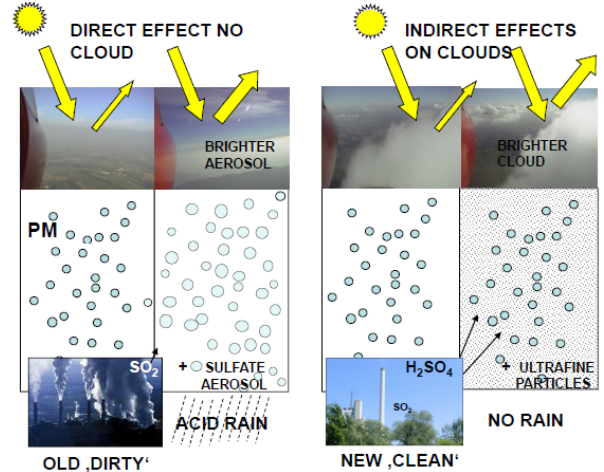
Fig. 1. Old versus new “clean” power plant emission: left (old Fig. 1: Old versus new ‘clean’ power plant emission: left (old power plant) - sulphur power plant) – sulphur dioxide increases the size and scattering co- efficient of particulate matter (PM), but not the number of existing dioxide increases the size and scattering coefficient of particulate matter (PM), but not the or co-emitted particles; right (new power plant) – directly emitted H 2 SO 4 increases the CCN number density and affects cloud micro- number of existing or co-emitted particles; right (new power plant) - directly emitted H physics by brighter clouds and precipitation suppression. increases the CCN number density and affects cloud microphysics by brighter clouds and precipitation suppression.